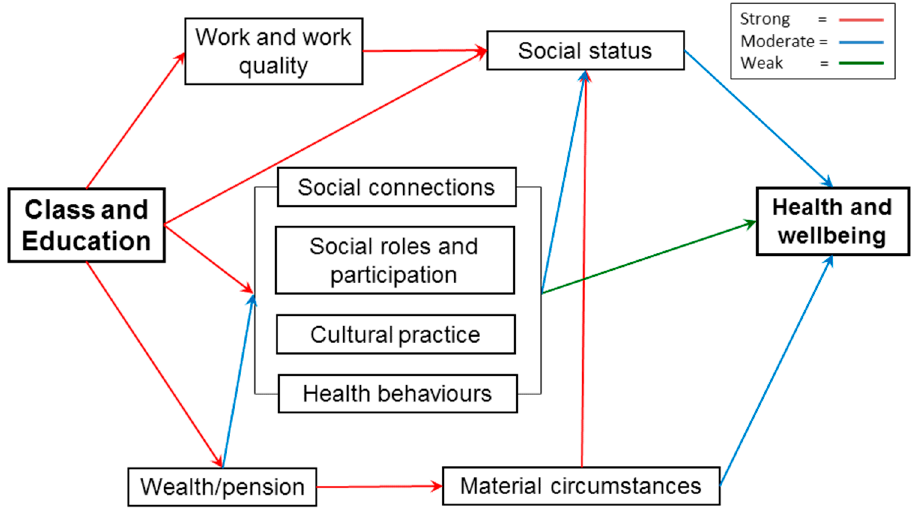
Figure 6. Causal mechanisms associating class with health and wellbeing in later life.